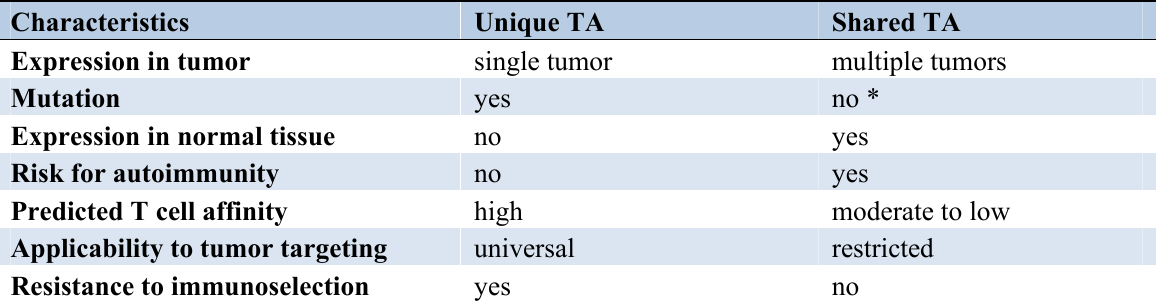
Table 2. Unique and shared tumor